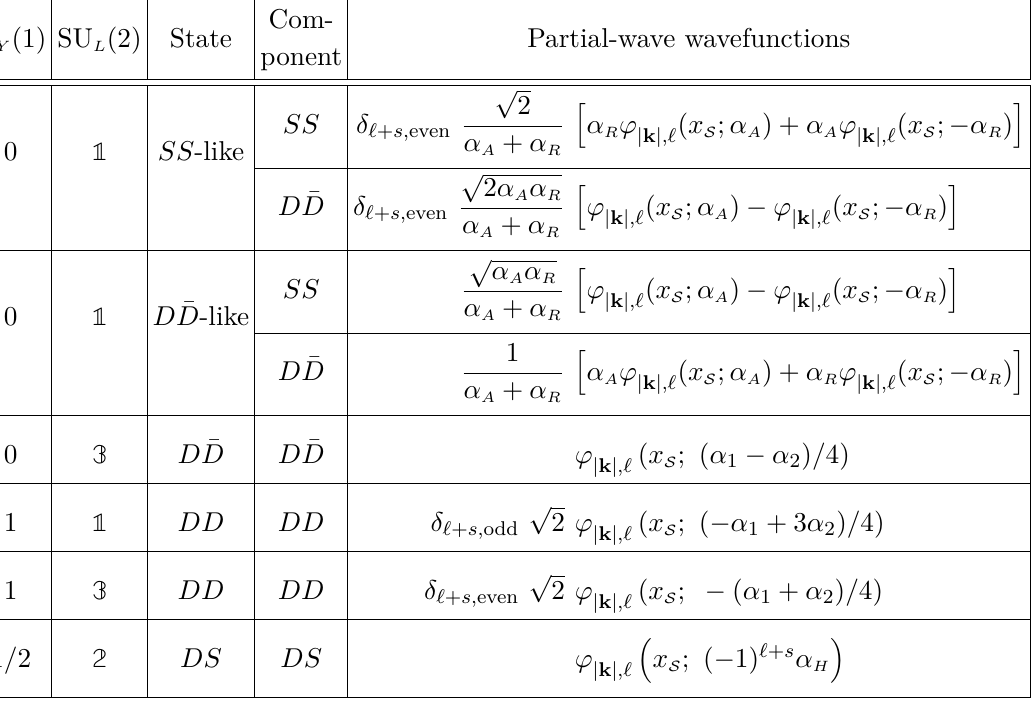
( x ; α ) → 0 . Here, ϕ H S | k | ,‘ and α , defined in eqs. (2.25), depend on ‘ + s . A R